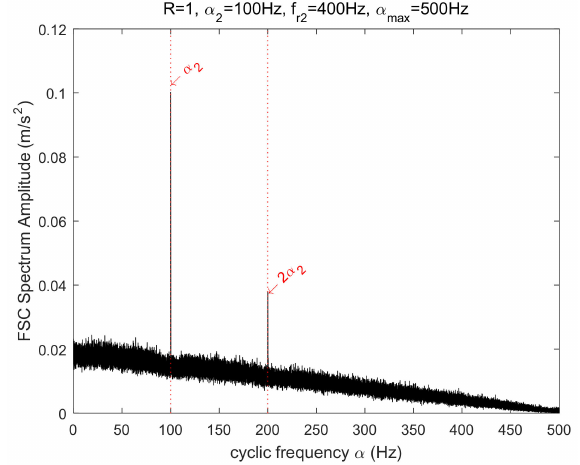
Figure 4. Vibration spectrum analyzed by cyclic modulation spectral-continuous wavelet transform (CMS-CWT).